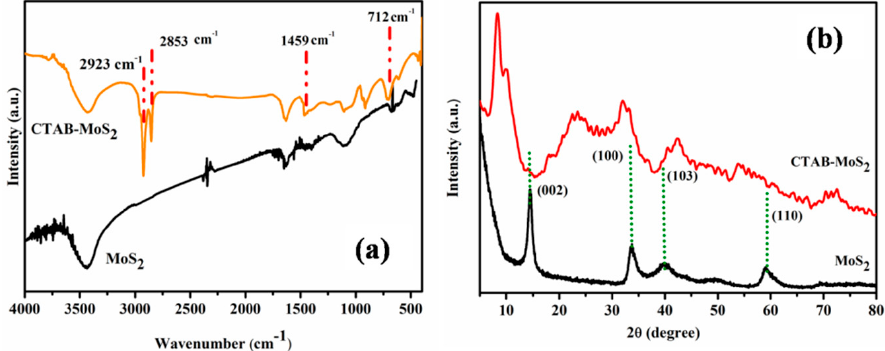
Figure 2. ( a ) FT-IR spectra for MoS 2 and CTAB–MoS 2 and ( b ) X-ray diffraction (XRD) pattern of MoS 2 and CTAB–MoS 2 .